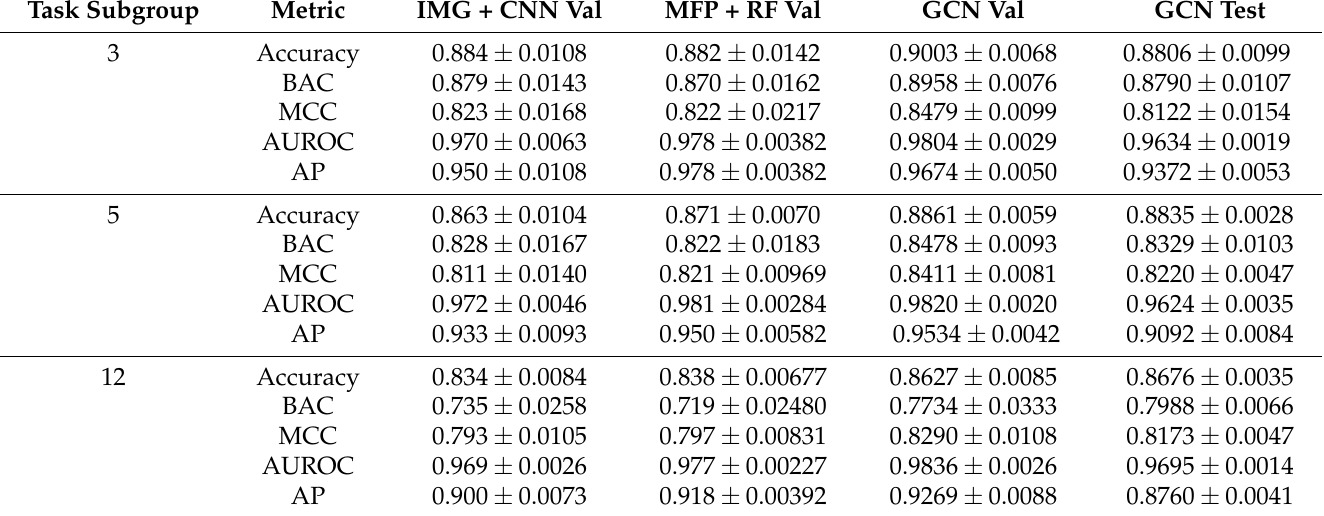
Table 3. Evaluation metrics showing results of the models’ performance on 3-, 5-, and 12-task subgroups. We first compare IMG + CNN and MFP + RF with our GCN model on cross validation. This information is provided in the columns IMG + CNN Val, MFP + RF Val, and GCN Val respectively. In the GCN Test column, we provide results of our GCN model on test